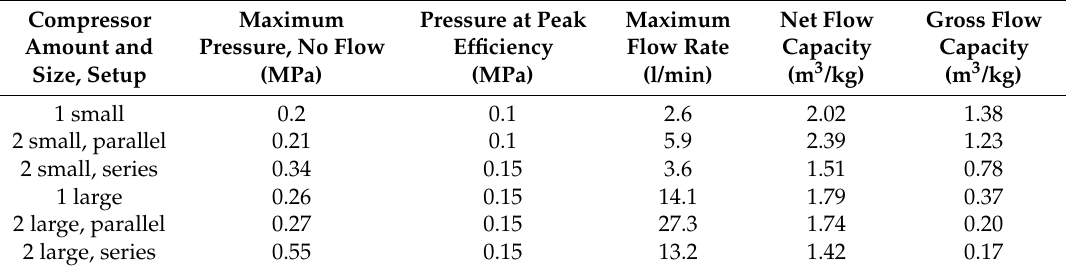
Table 2. Key experimental values regarding pressure generation, flow rate, and flow capacities of small and large diaphragm compressors, based on